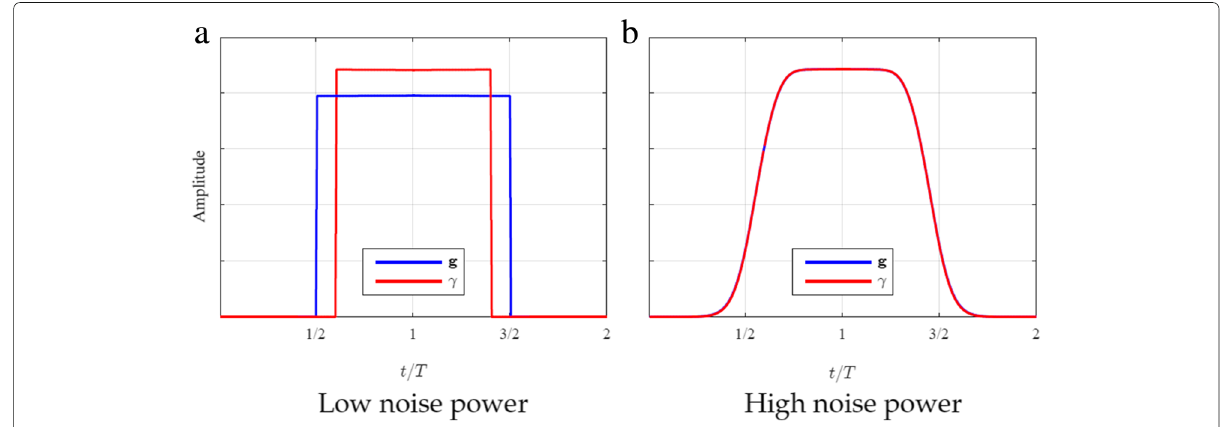
Fig. 13 a , b Pulse shapes designed for time-invariant channel